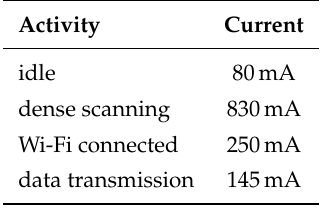
Table 2. Current consumption of the